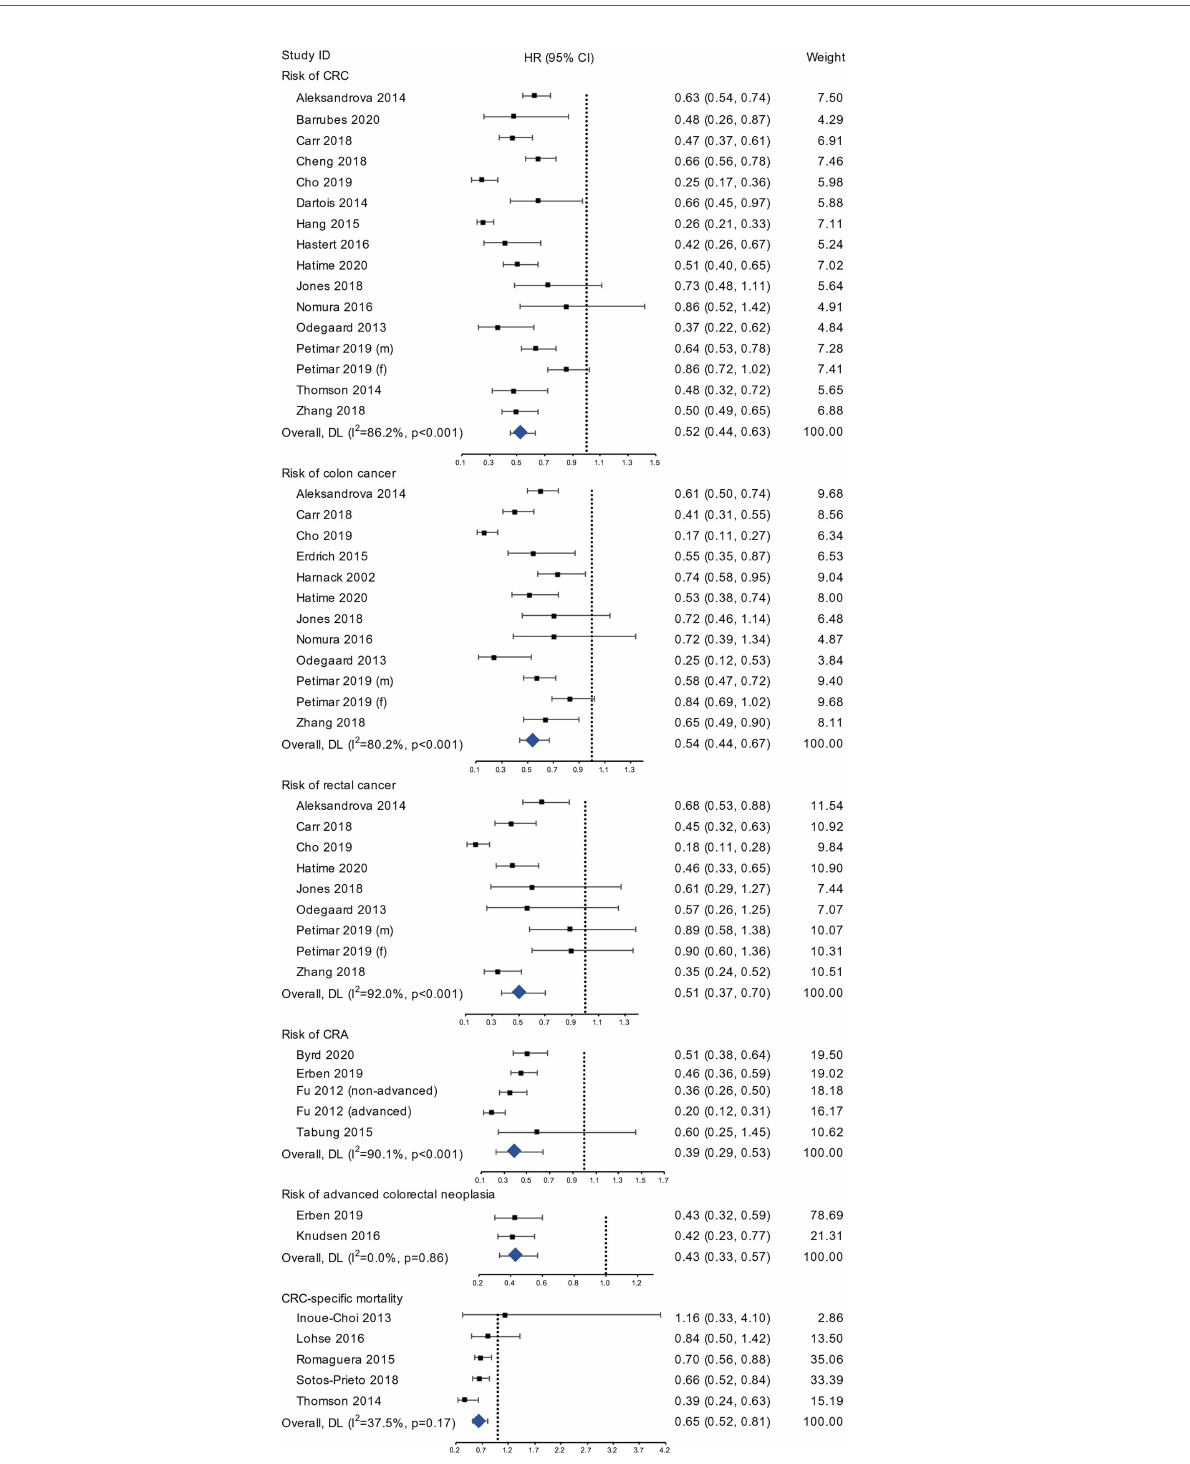
Frontiers in Oncology |